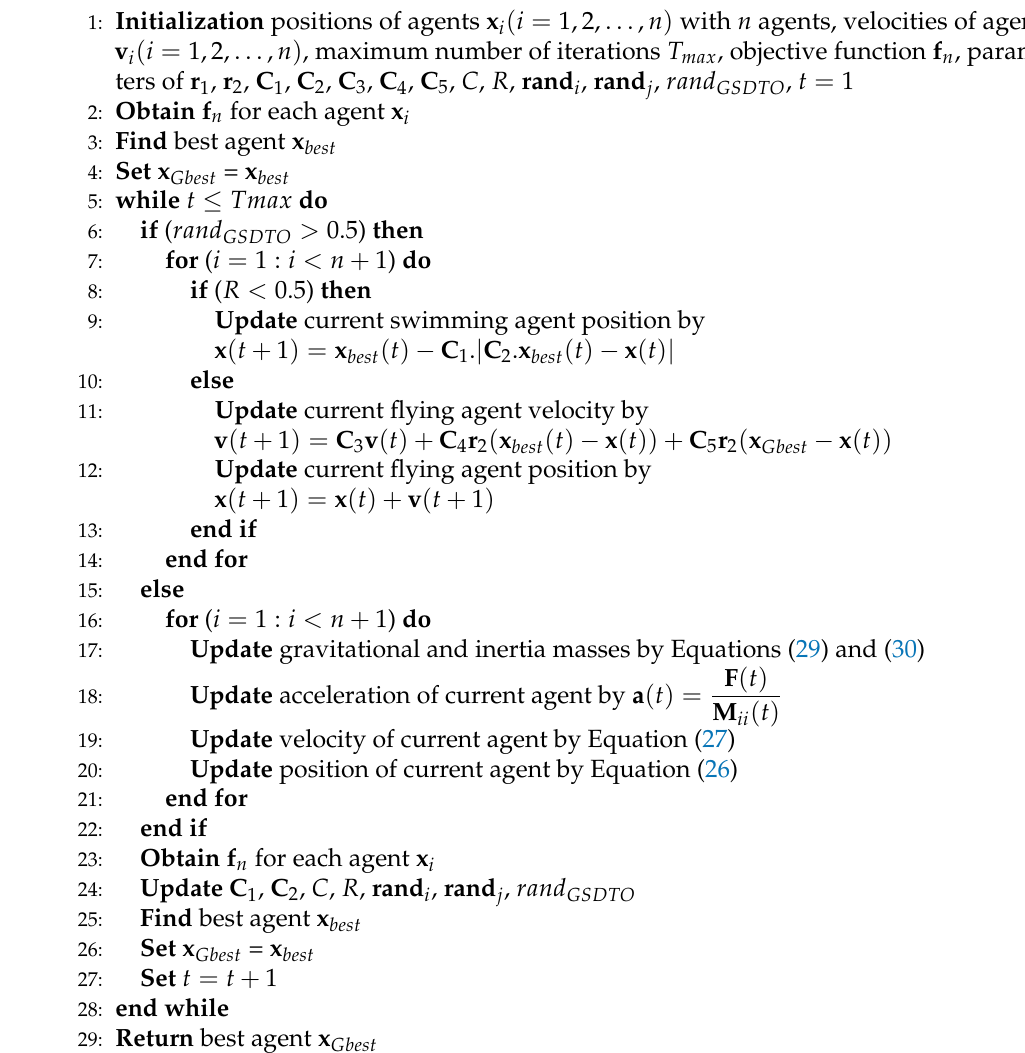
Algorithm 3 Proposed GSDTO